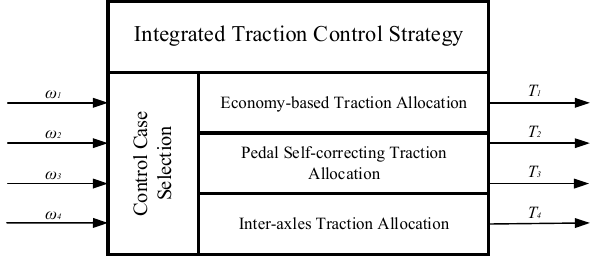
Figure 3. Schematic of the proposed integrated control strategy.